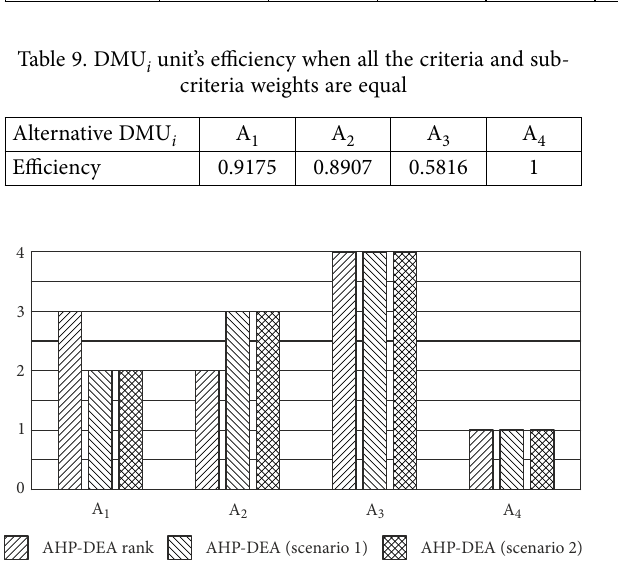
Figure 20. Sensitivity analysis of alternative ranking in DEA model